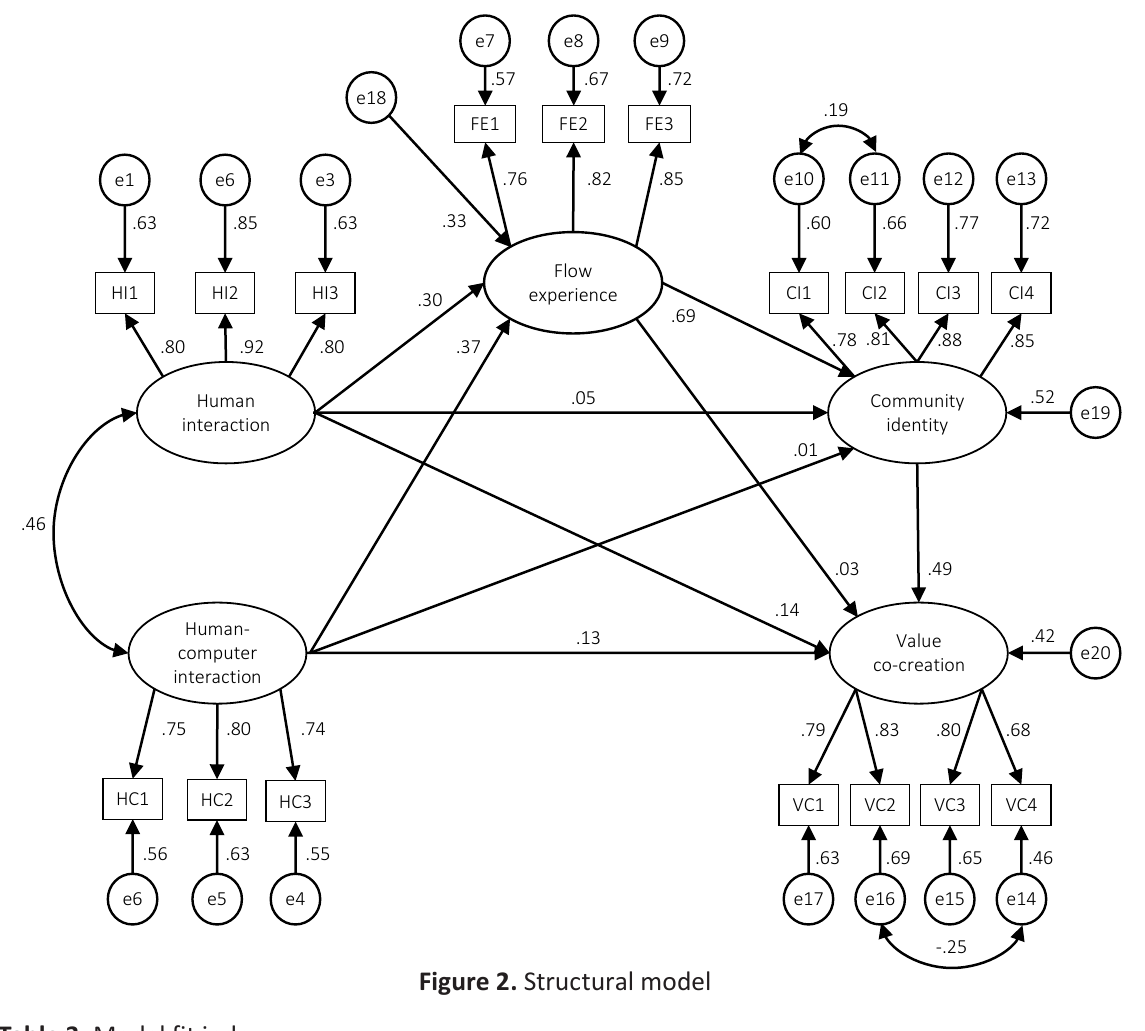
Table 3. Model fit